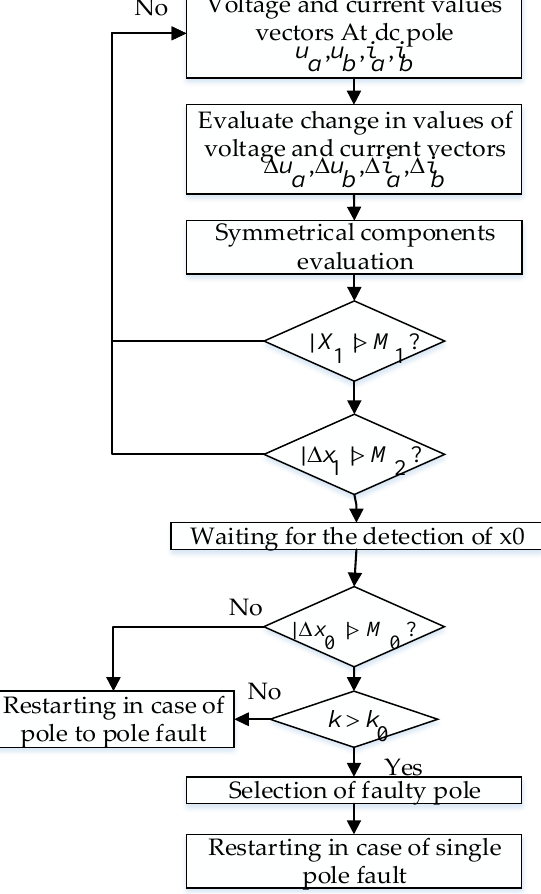
Figure 15. Protection scheme for bipolar high-voltage direct current (HVdc) transmission system.